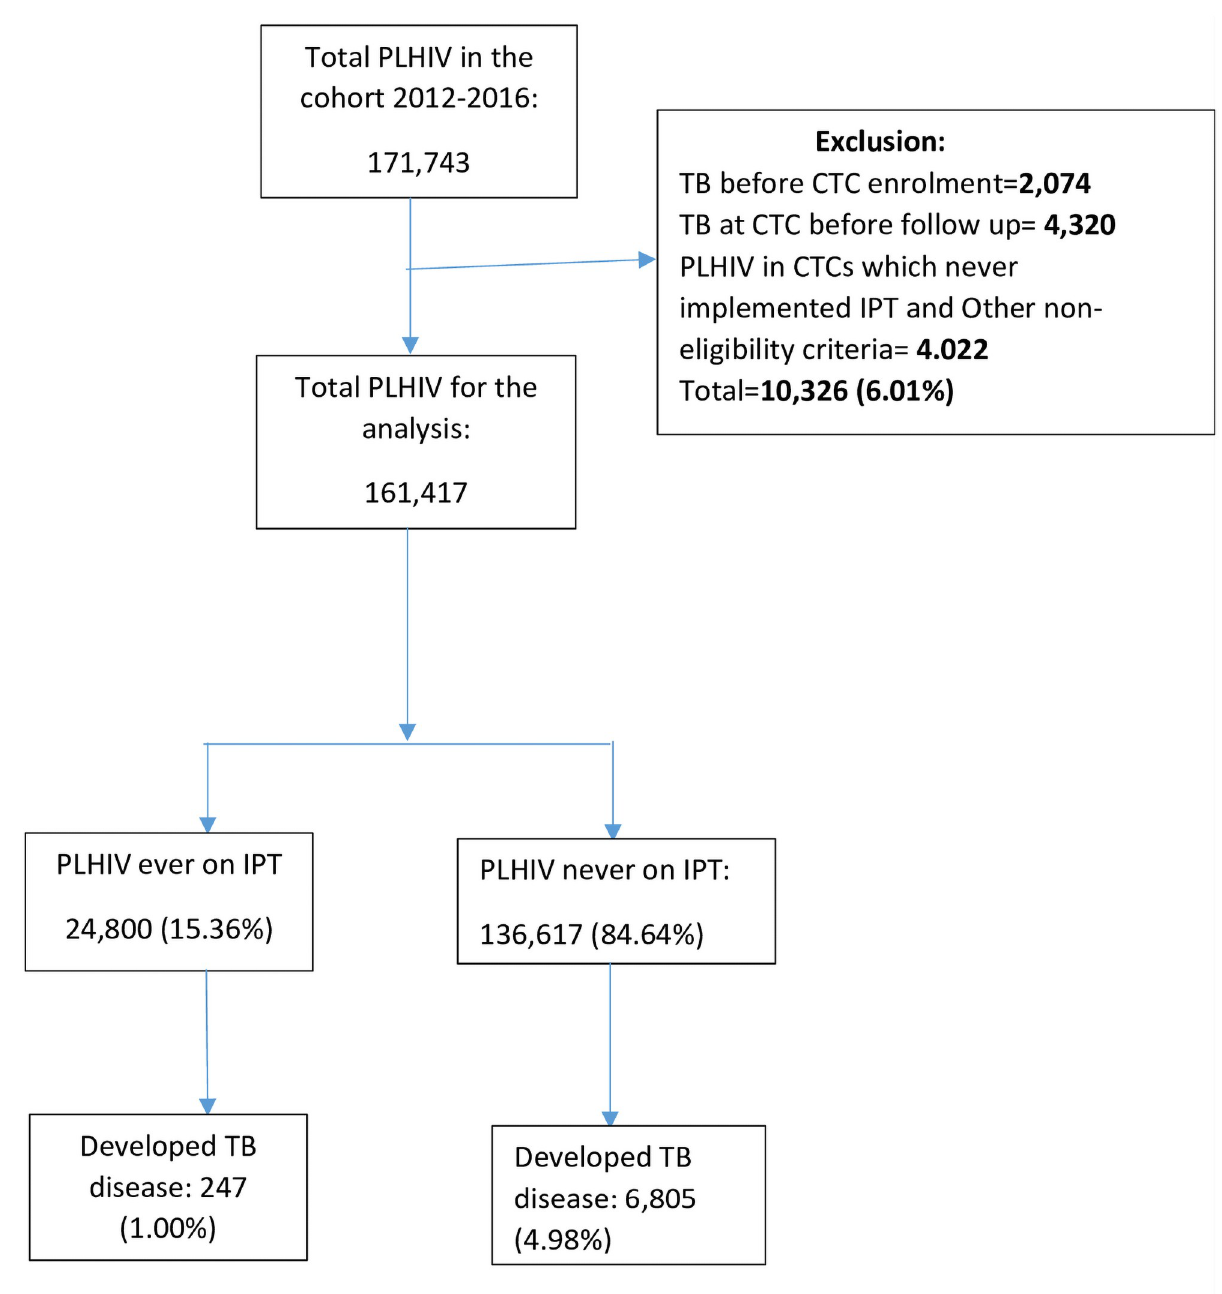
Fig 1. Flow diagram for Isoniazid Preventive Therapy and TB diagnosis among PLHIV. The figure showed only 15.36% of the PLHIV in the study were initiated on Isoniazid Preventive Therapy. When compared, less PLHIV who ever used IPT developed TB disease (1.00%) than those who did not use IPT